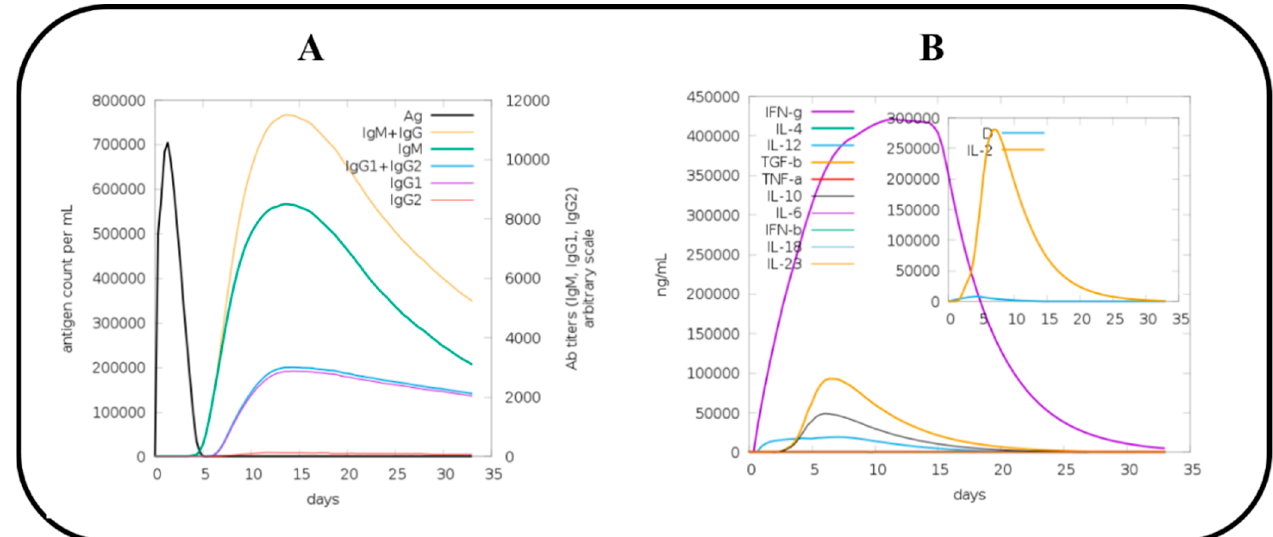
Figure 11. C immune simulation results of MEV construct.